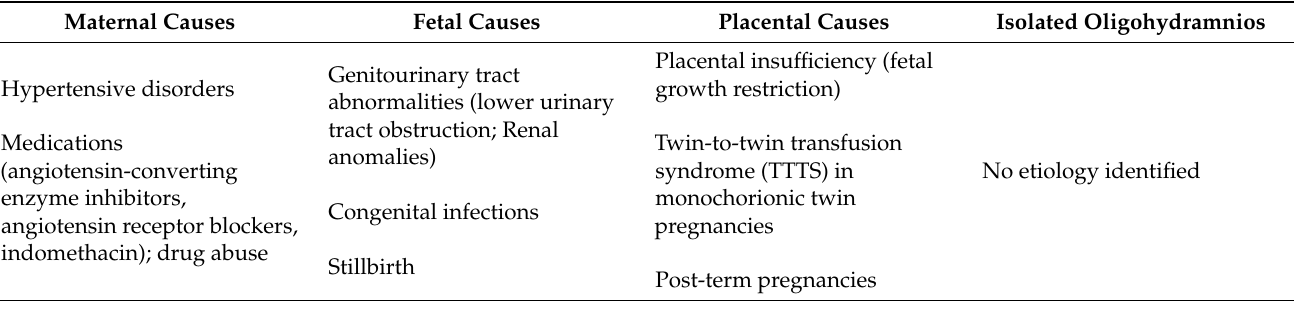
Table 1. Oligohydramnios: etiologies.